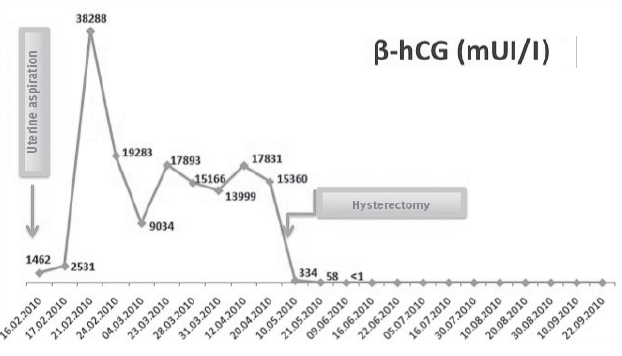
figurE 1 – Time evolution of serum β -hCG levels (Hospital Prof. Dr. Fernando Fonseca, Amadora, Portugal) β -hCG: beta subunit of human chorionic